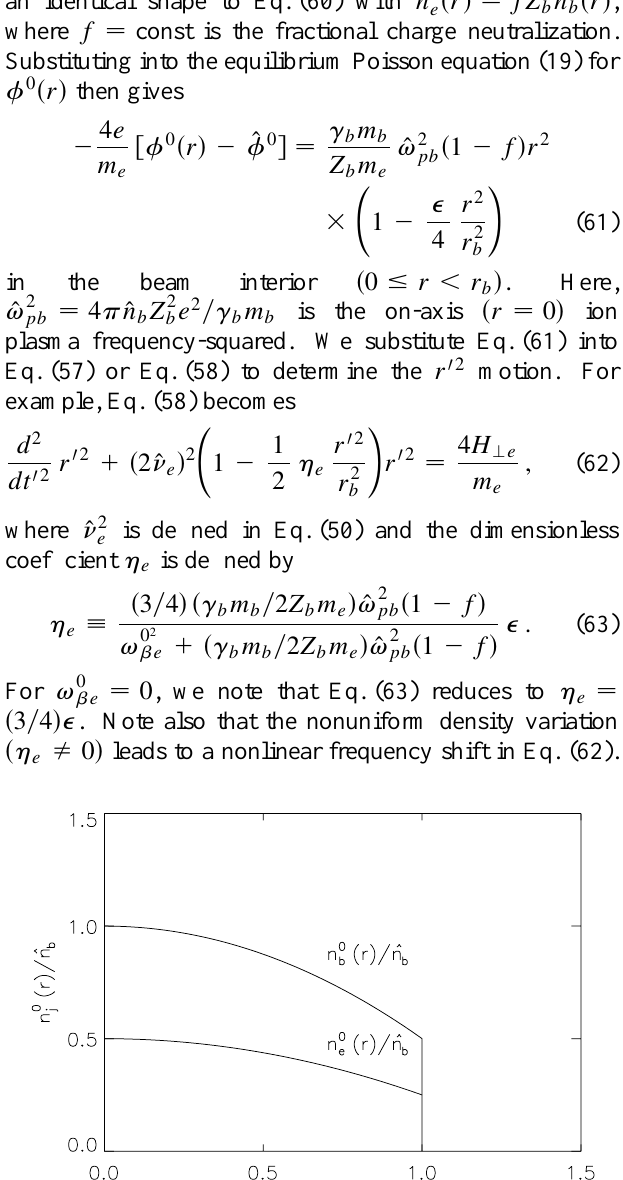
(cid:48) (cid:115) (cid:114) (cid:100) (cid:173) (cid:90) (cid:115) (cid:114) (cid:100) . For the purpose of (cid:98) (cid:102)(cid:110) (cid:98) (cid:101)